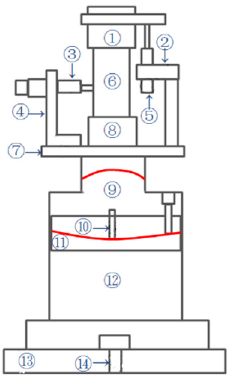
Figure 4. Specimen loading diagram: ① upper bearing plate; ② axial displacement sensor gripper; ③ transverse displacement sensor; ④ transverse displacement sensor mounting seat; ⑤ axial displacement sensor; ⑥ sample; ⑦ sensor mounting plate; ⑧ lower bearing plate; ⑨ bearing seat ⑩ locating pin; ⑪ adjustment plate; ⑫ foundation support; ⑬ baseboard; and ⑭ located block.